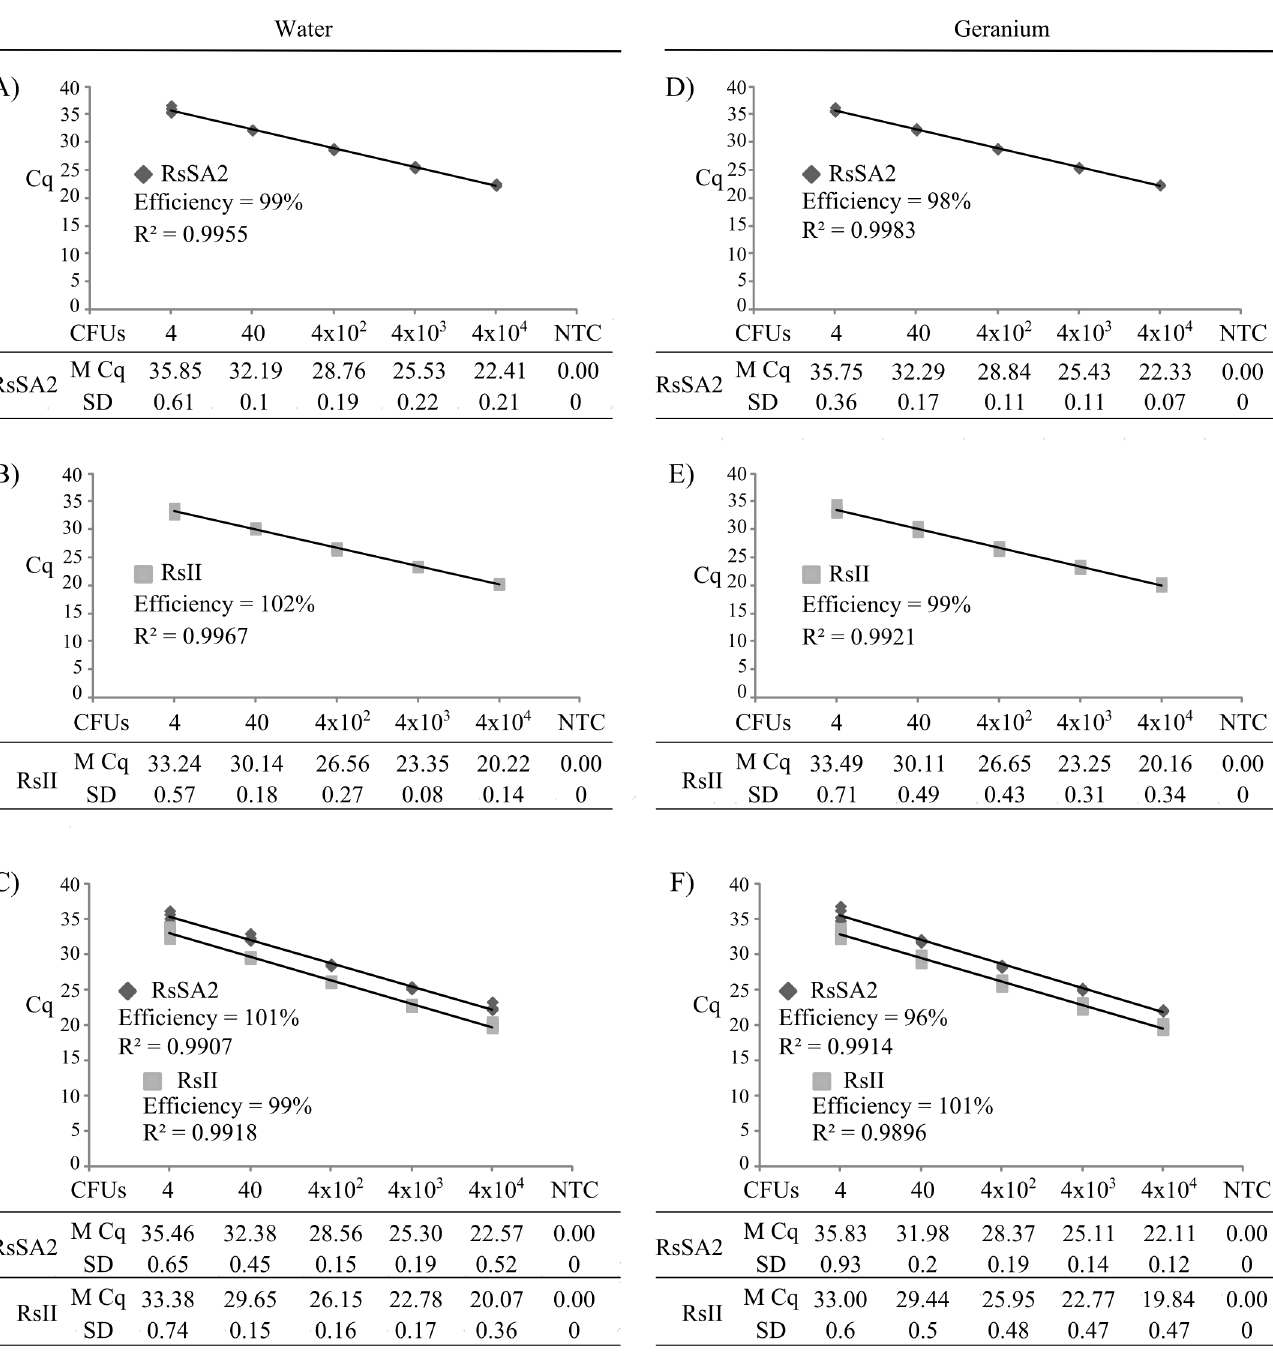
Fig 1. Comparison of efficiency and sensitivity for RsSA2 (A, C, D, F) and RsII (B, C, E, F) sets under both uniplex (A, B, D, E) and multiplex qPCR (C, F) conditions with 10-fold serial dilutions of Ralstonia solanacearum strain UW551 cells diluted in either sterile water or Qiagen-purified healthy geranium extracts. Mean (M) Cq value and standard deviation (SD) for each bacterial colony forming unit (CFU) was calculated from 4 replicates in two separate experiments. NTC: no template water